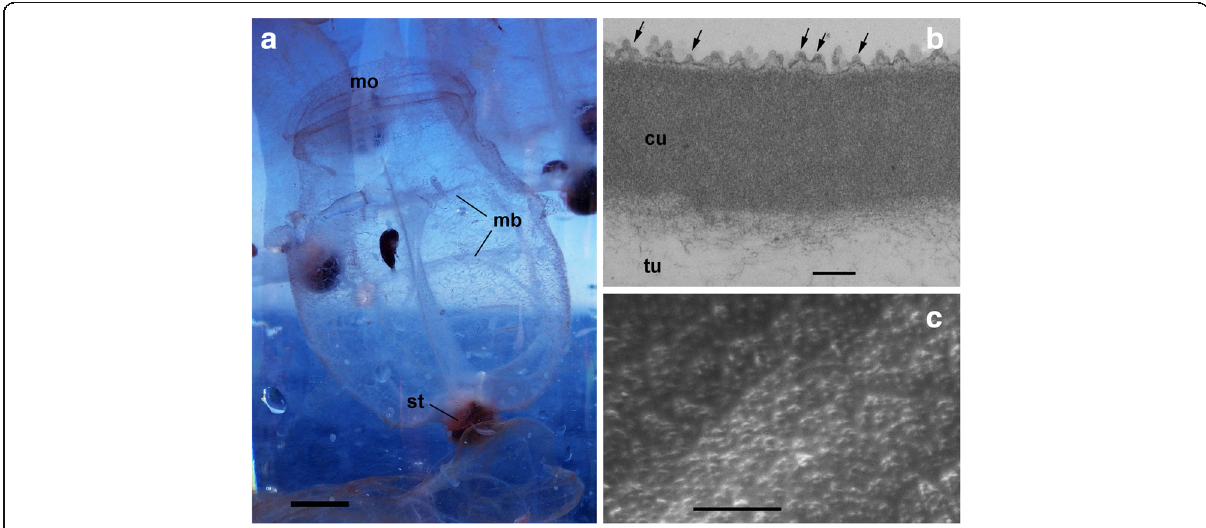
Fig. 1 Zooids and tunic of Pegea confoederata . a Aggregate zooids alive onboard. b Cross section of the tunic cuticle (TEM). c Protrusions on the tunic surface (SEM). Arrows indicate some of the protrusions on the tunic cuticle (cu). mb, muscle band; mo, mouth; st, stomach; tu, tunic matrix. Scale bars: 1 cm in ( a) , 0.2 μ m in ( b) , 1 μ m in (